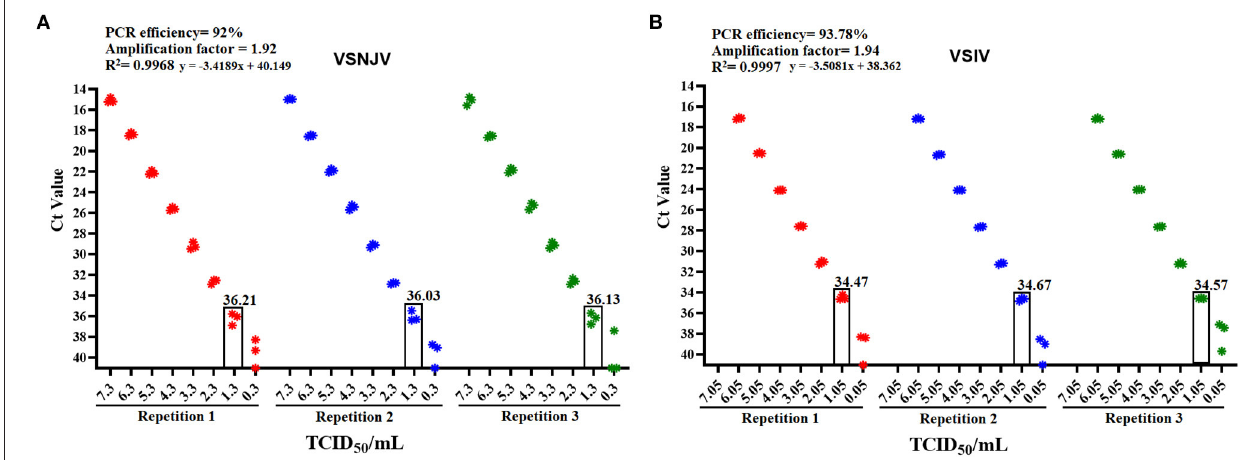
FIGURE 3 | Determination of the amplification efficiency and the analytical sensitivity values of the 2021 protocol using reference strains of each serotype. Initial validation of the 2021 protocol was conducted on the (A) VSNJV and (B) VSIV components of this protocol. In each graphic are depicted values of PCR efficiency, amplification factor, and R 2 correlation values associated with the PCR efficiency. The analytical sensitivity of each component is shown in the rectangle that corresponds to the last dilution where all three replicates were